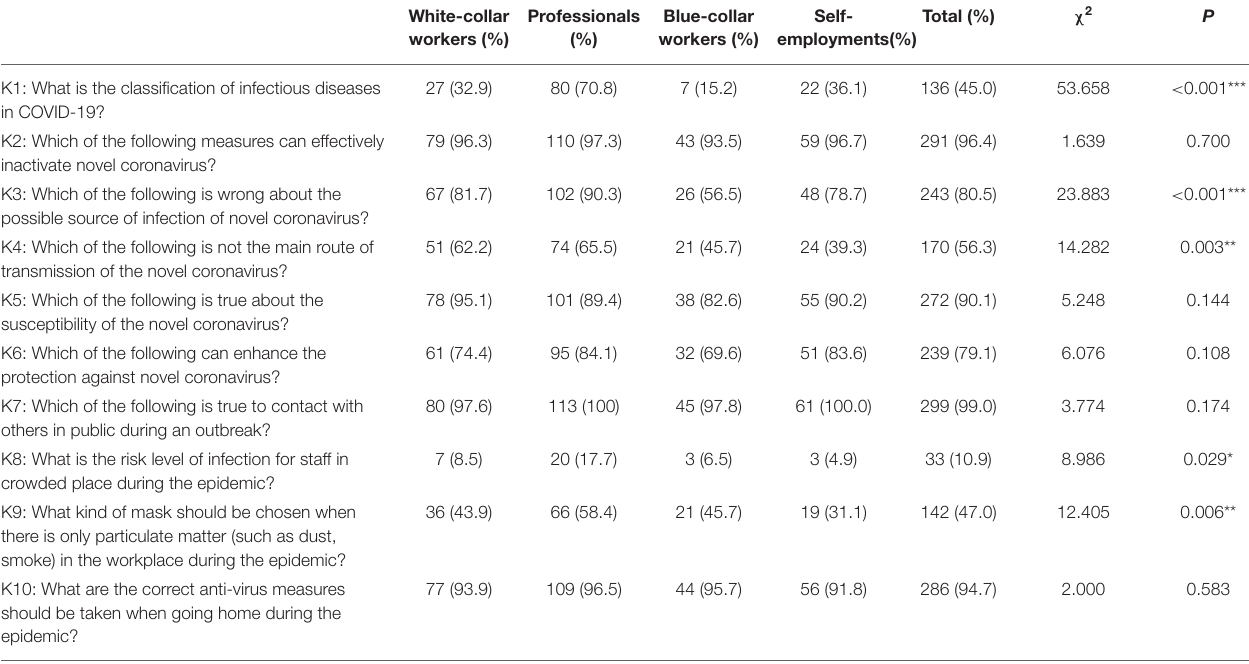
TABLE 3 | Comparison of knowledge level of people returning to work in different occupations regarding COVID-19.